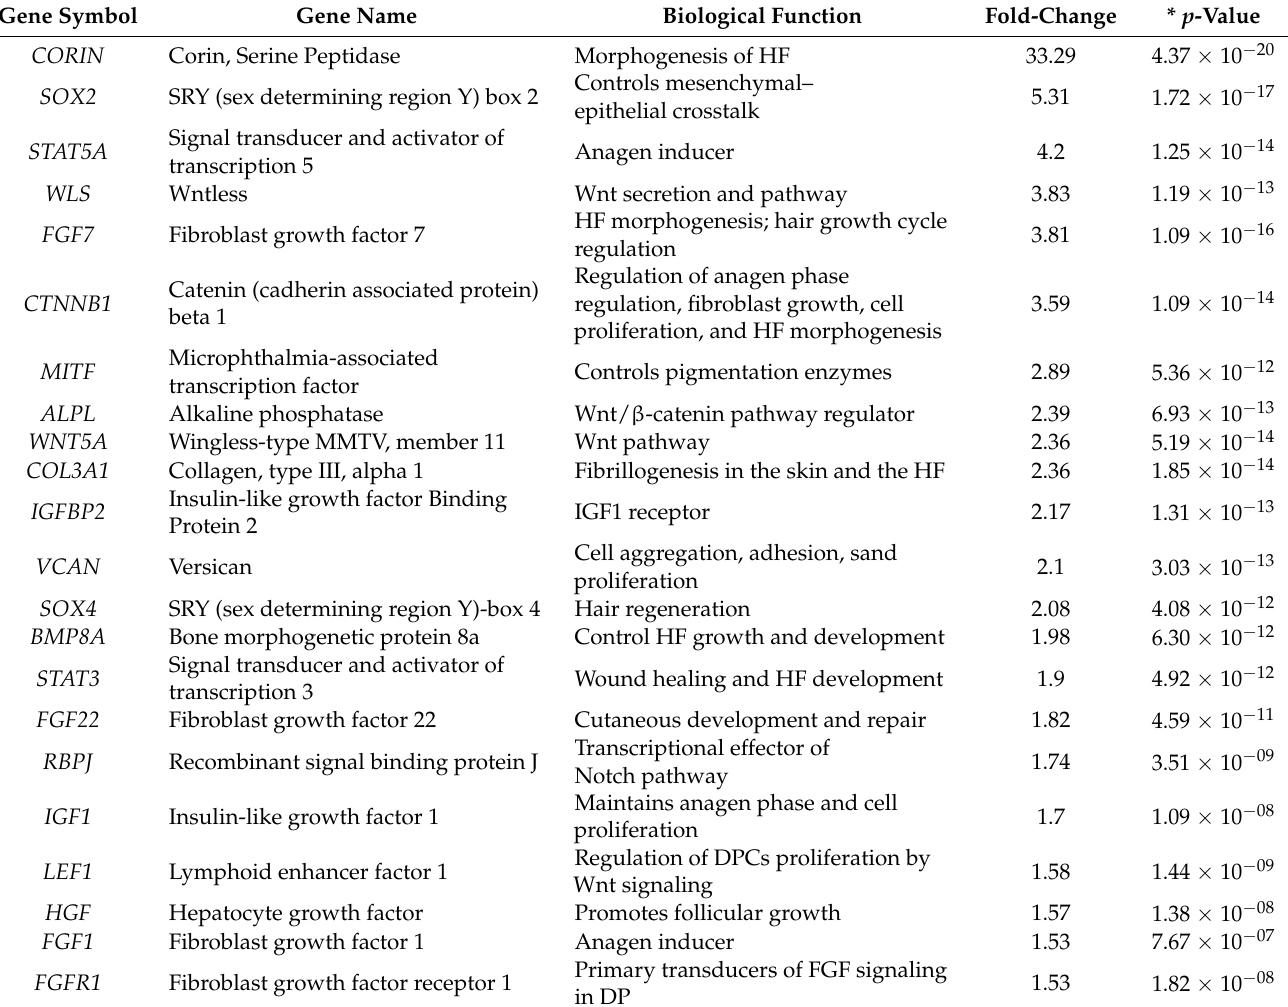
Table 1. Summary of the top upregulated hair growth-associated genes by